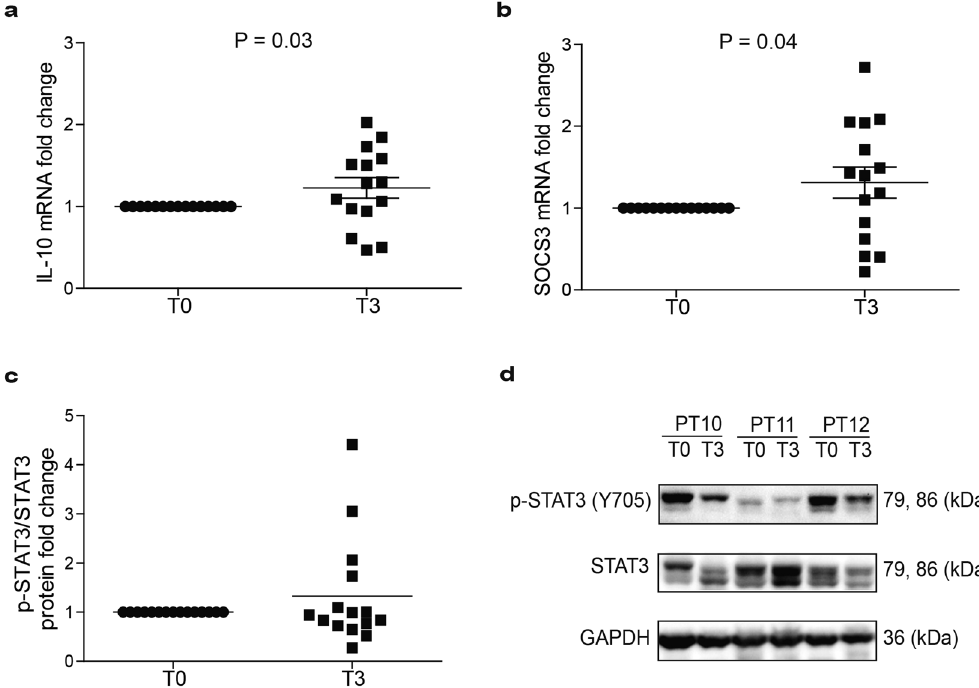
Figure 3. mRNA expression levels of (a) IL-10 and (b) SOCS3 . Protein levels of (c) p-STAT3/STAT3 on homogenized sigmoid colon tissues in compliant and responder patients (n = 15) at T0 and T3. Statistical significance was obtained using one-sample two-tailed t-test. Data are shown as mean of square root transformed values ± SEM. (d) Western blot representative images of p-STAT3 (Y705) and STAT3 at T0 and T3 (n =